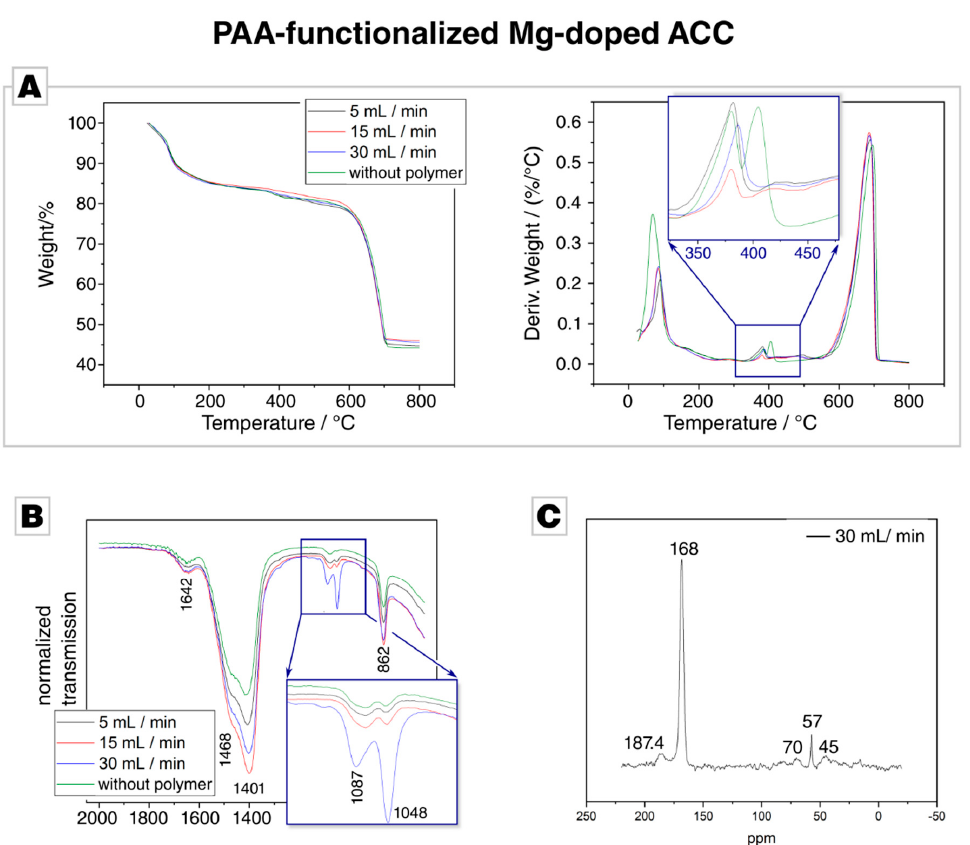
Figure 4. ( A ) Thermal gravimetric analysis of the PAA experiments and the Mg-doped ACC control sample. The different PAA-functionalized samples show no significant variation. ( B ) Fourier